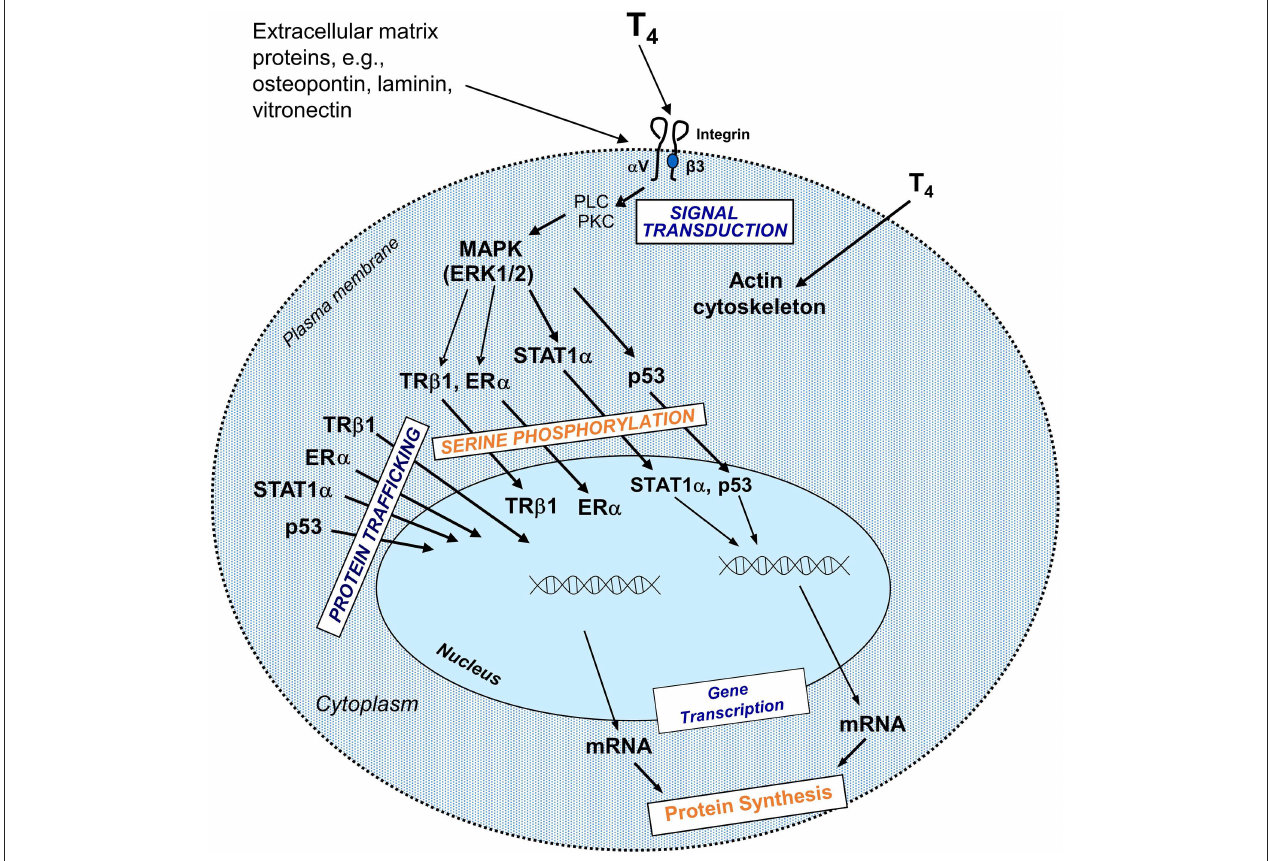
FIGURE 2 | Non-genomic actions of the hormone that begin at integrin α v β 3 include regulation of intracellular trafficking of specific proteins to the nucleus and serine phosphorylation of some of these proteins in the course of nuclear entry. Directed to the nucleus from the cytoplasm, some of these proteins might be involved in modulation of transcription of specific genes and in cell proliferation. These pathways depend on activation of phospholipase C (PLC), protein kinase C (PKC), mitogen activated protein kinase (MAPK)1, and MAPK2. T4 non-genomically rapidly activates actin polymerization in hypothyroid astocytes and osteoblastic cells (15). Reprinted with permission from Hercbergs et al. (